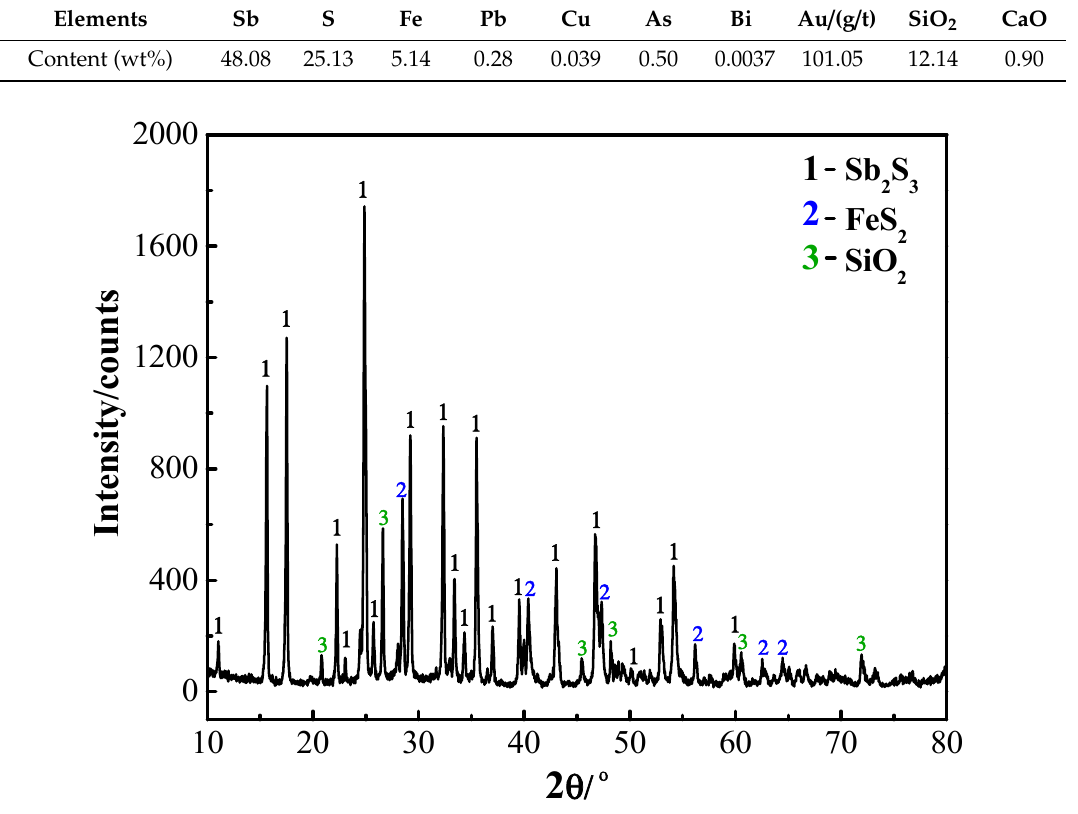
Table 1. Chemical composition of central south stibnite concentrate. Table 2. Chemical composition of reductant coal in pilot scale experiments.